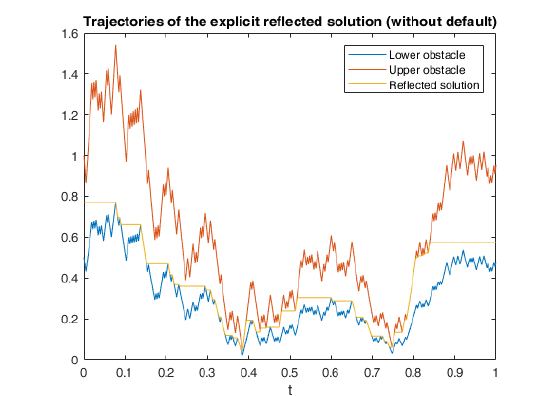
Figure 11. The paths of Y π , α in the explicit reflected scheme without default